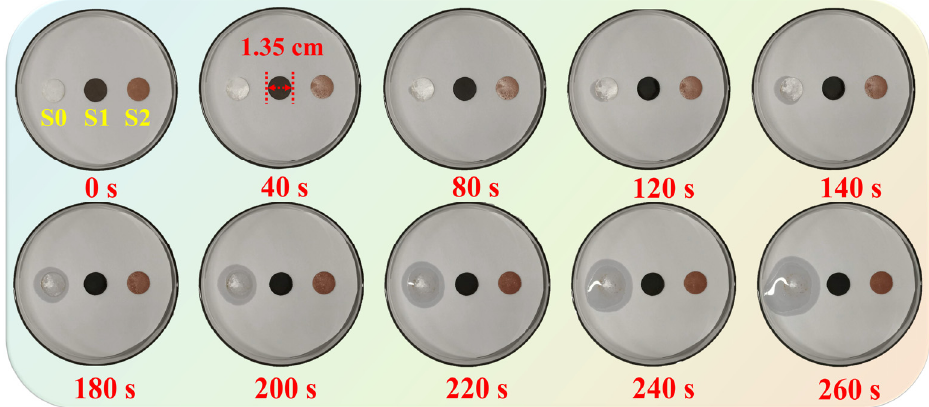
Figure 10. D i gital photographs of (S0) pure n -docosane, (S1) SiO 2 /Fe 3 O 4 -MEPCM, and (S2) BiOI- MEPCM during the isothermal heating process.